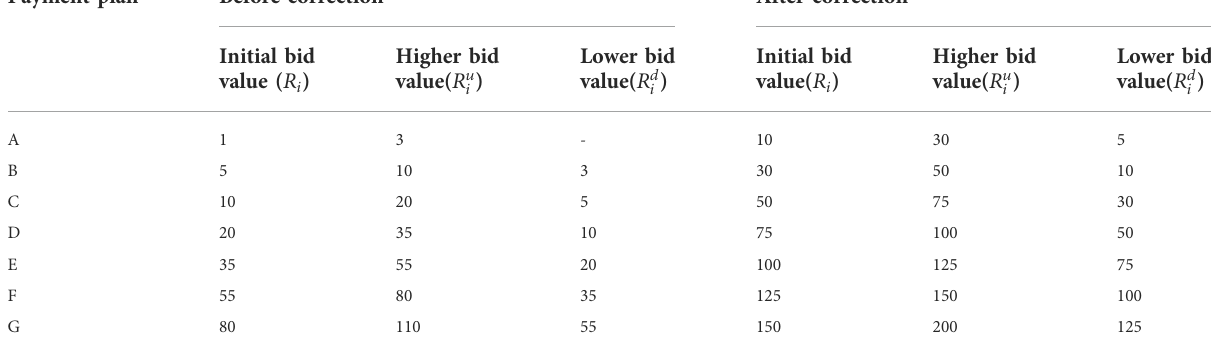
TABLE 2 Design scheme before and after bid value revision. Payment plan